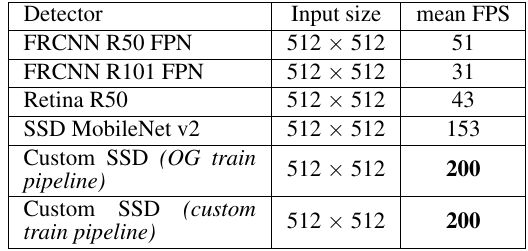
Figure 3. Visualized detection results for all tested detection models on a sample test image.